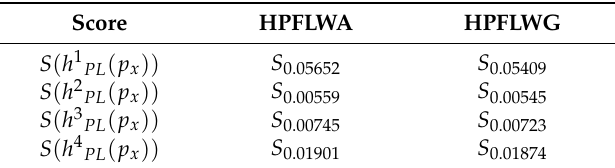
Table 8. Score values for the alternatives using HPFLWA and HPFLWG operators.